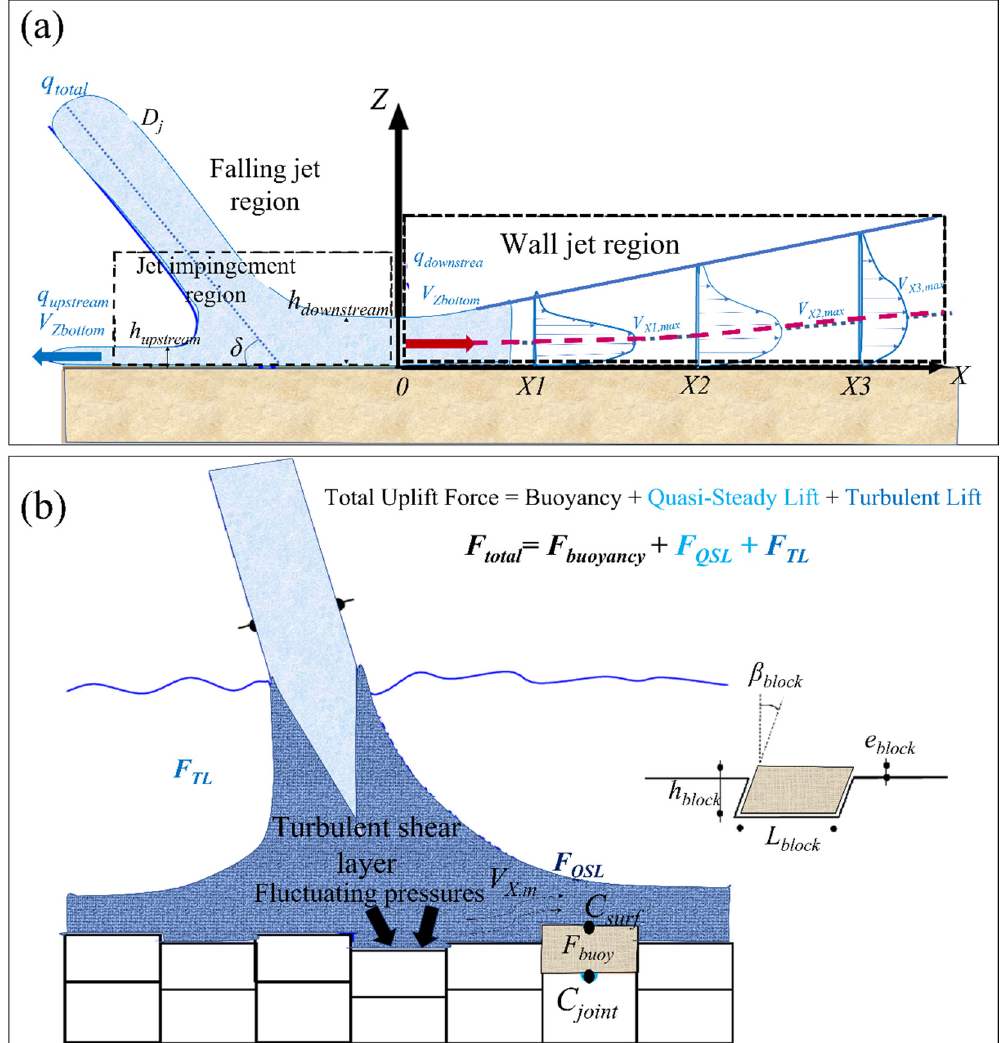
Figure 15. ( a ) Plane jet deflection on a flat bottom and wall jet velocity profiles; ( b ) effective forces on block uplift [81].